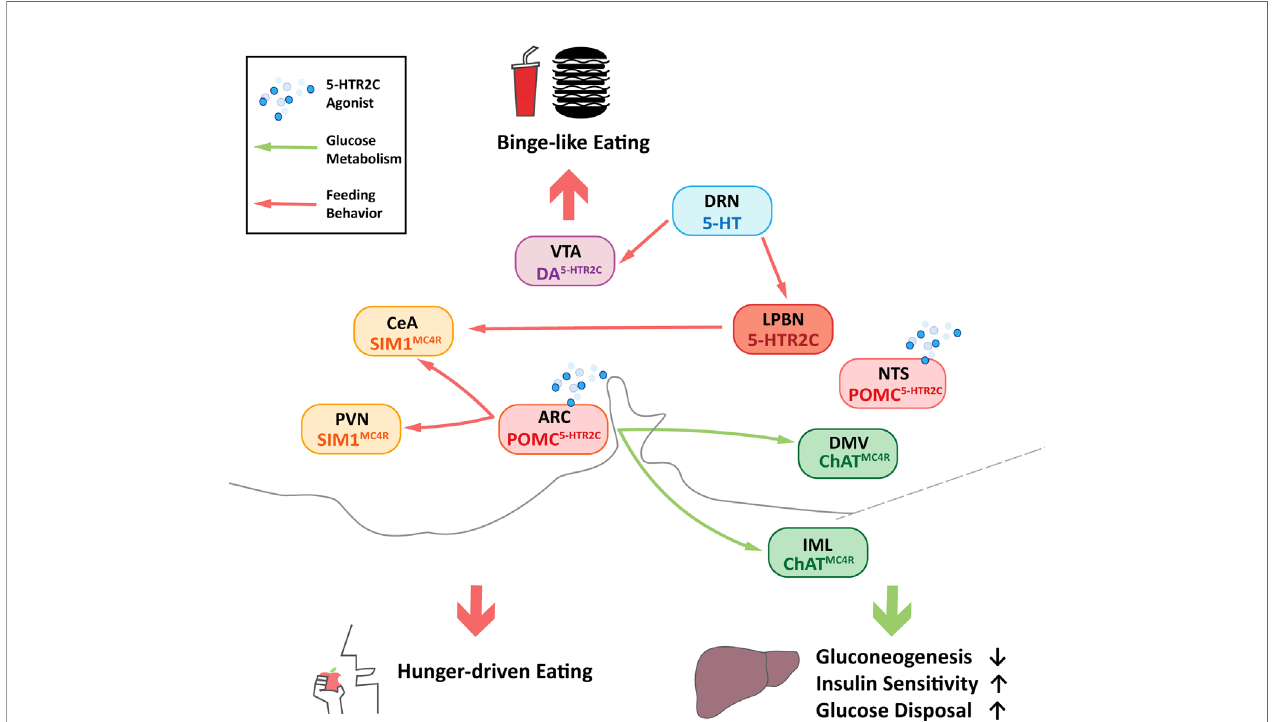
FIGURE 2 | Central neuronal circuits of 5-HTR2C that regulate feeding behavior and glucose homeostasis. Central Nervous System (CNS) 5-hydroxytryptamine receptor 2C (5-HTR2C) may regulate energy metabolism through neuronal circuits. Red arrows designate circuits that regulate three types of feeding behavior which are binge-like eating, sodium intake and hunger-driven eating, while the green arrows show the circuits that regulate glucose homeostasis by reducing gluconeogenesis, increasing insulin sensitivity and glucose disposal. Pink boxes indicate nuclei containing POMC neurons that co-express 5-HTR2C (POMC 5-HTR2C ); Green boxes indicate nuclei containing cholinergic neurons that co-express melanocortin 4 receptors (ChAT MC4R ); Yellow boxes indicate nuclei containing single minded-1 (SIM1) neurons that co-express melanocortin 4 receptors (SIM1 MC4R ); Light purple box indicates nuclei containing DA neurons that co-express 5-HTR2C (DA 5-HTR2C ); Light blue box indicates nuclei containing 5-HT neurons and orange box indicates nuclei containing a subset of neurons expressing 5-HTR2C. ARC, arcuate nucleus; NTS, nucleus tractus solitarius; PVN, paraventricular nucleus of the hypothalamus; CeA, central amygdala; LPBN, lateral parabrachial nucleus; DRN, dorsal raphe nucleus; VTA, ventral tegmental area; DMV, dorsal motor nucleus of the vagus; IML, intermediolateral